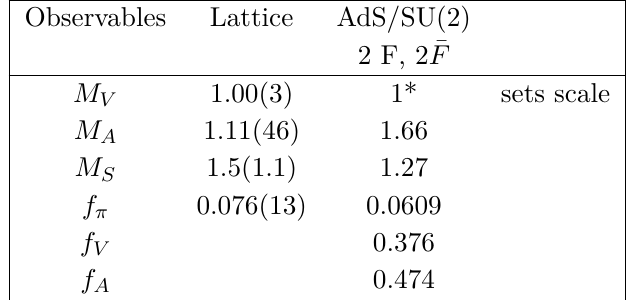
Table 3. Comparison of the lattice studies [77, 78] of the massless SU(2) gauge theory to our holographic model’s predictions for meson masses and decay constants in units of the vector me- son mass.